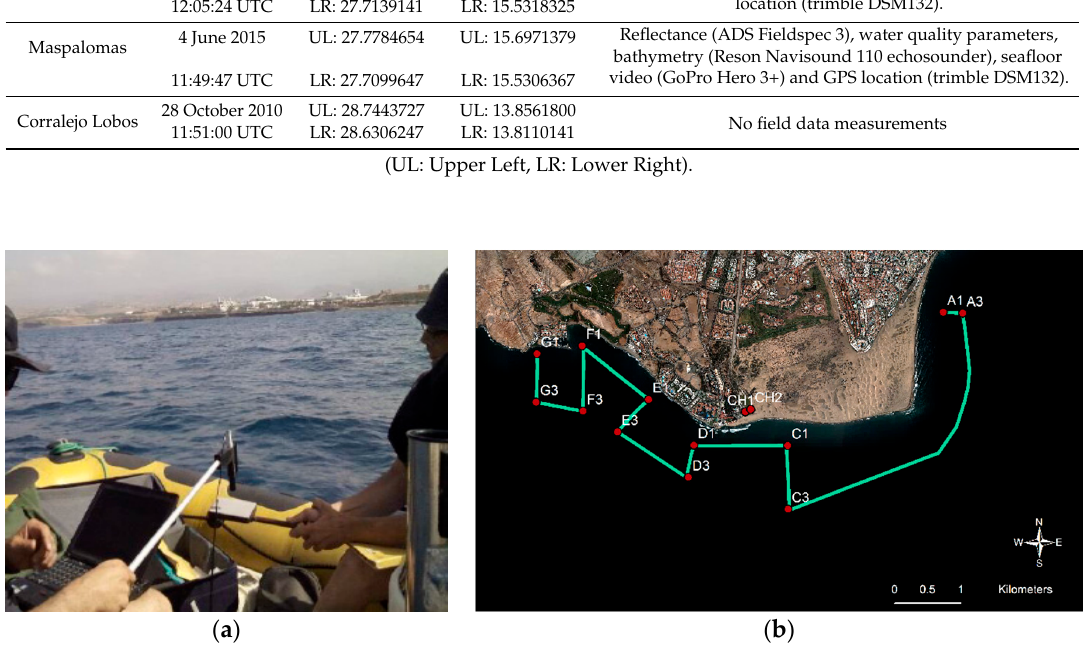
Figure 2. ( a ) Procedure of ground-based spectral data acquisition with the ADS Fieldspec 3 and; ( b ) ship transects and sampling sites during the Maspalomas field campaign of June